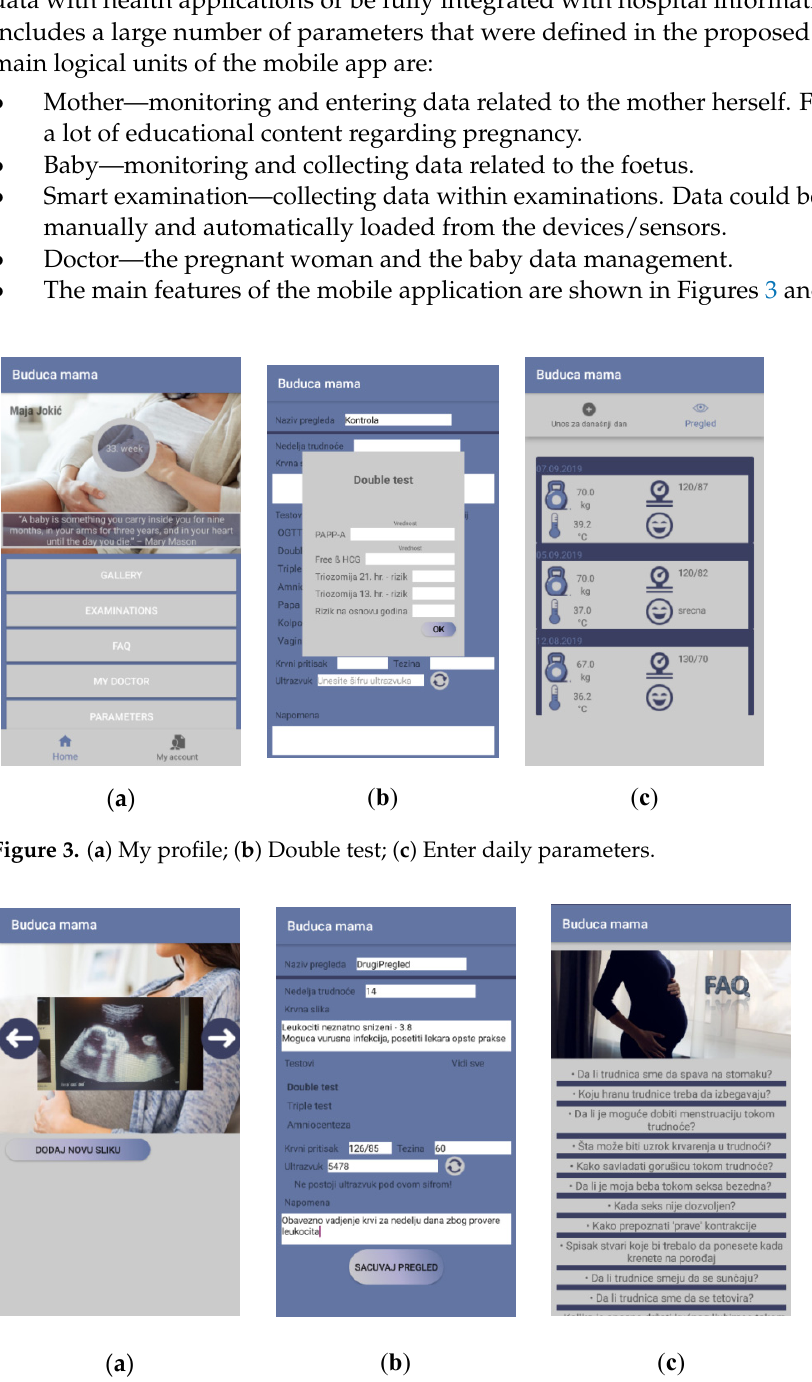
Figure 4. ( a ) Image from ultrasound device; ( b ) Data from ultrasound device; ( c )